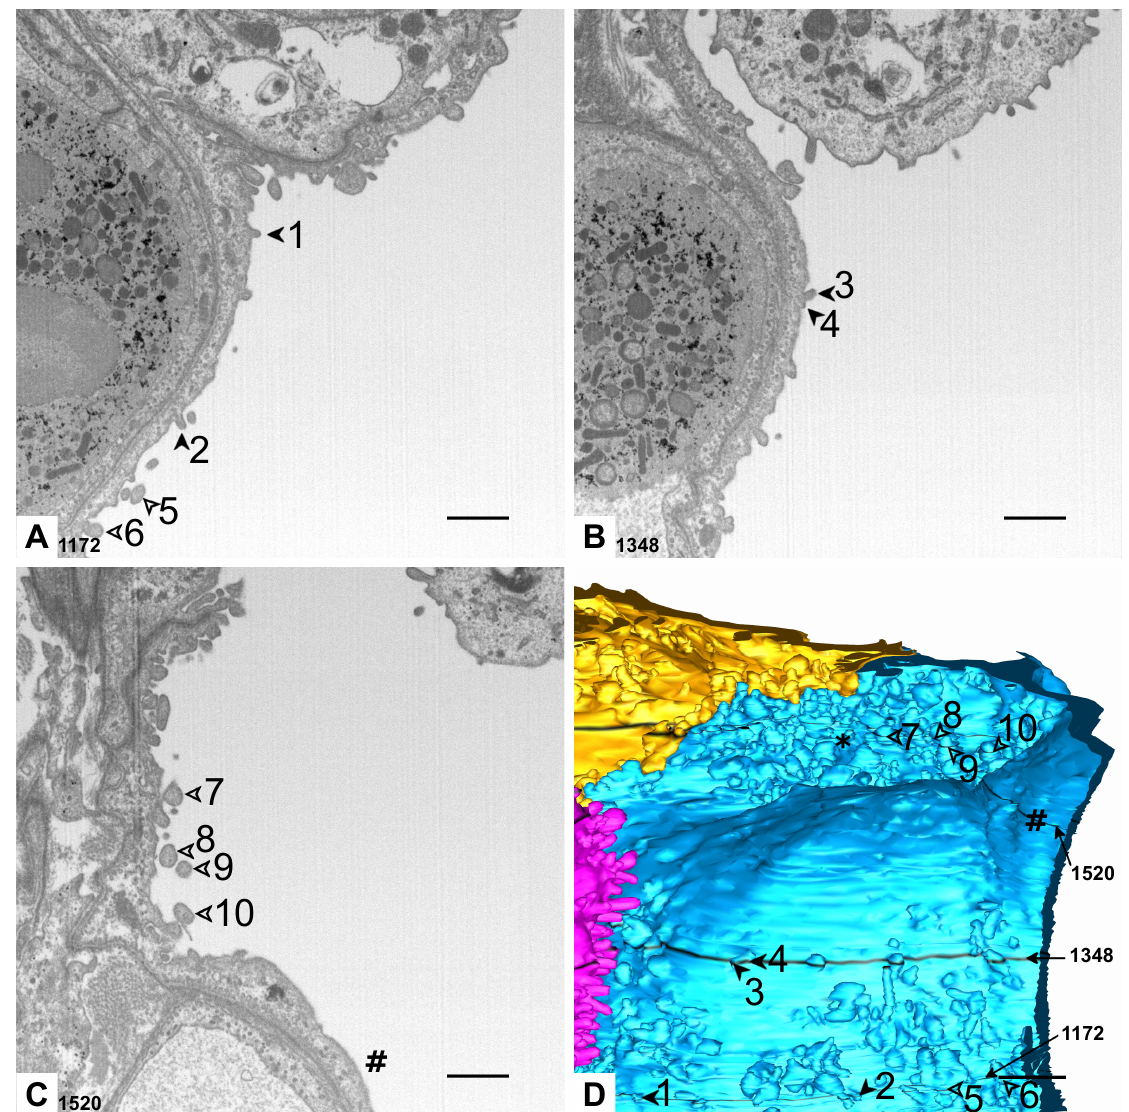
Figure 4. Luminal surface of AE1 cells. ( A–C ) Images 1172, 1348 and 1520 of the dataset. Filled arrowheads 1 and 2 ( A ) indicate profiles of microvilli. Filled arrowheads 3 and 4 ( B ) indicate microvilli with a shared basis. Empty arrowheads 5 and 6 ( A ) and 7–10 ( C ) indicate profiles of plasma membrane protrusions filled with cytoplasm. The hash key indicates a region with smooth AE1 luminal surface. ( D ) Detail of the 3D model. Arrowheads and hash key refer to the particular profiles in A–C. The particular section planes 1172, 1348 and 1520 are labeled and emphasized by black color in the model. The different thickness of these black markings is caused by different segmentation intervals in these regions. Note the smooth surface of the cell in the center of the image and the surface enlargements around. Some of them seem to be concentrated in a surface cavity (asterisk). Scale bars: 1 µ